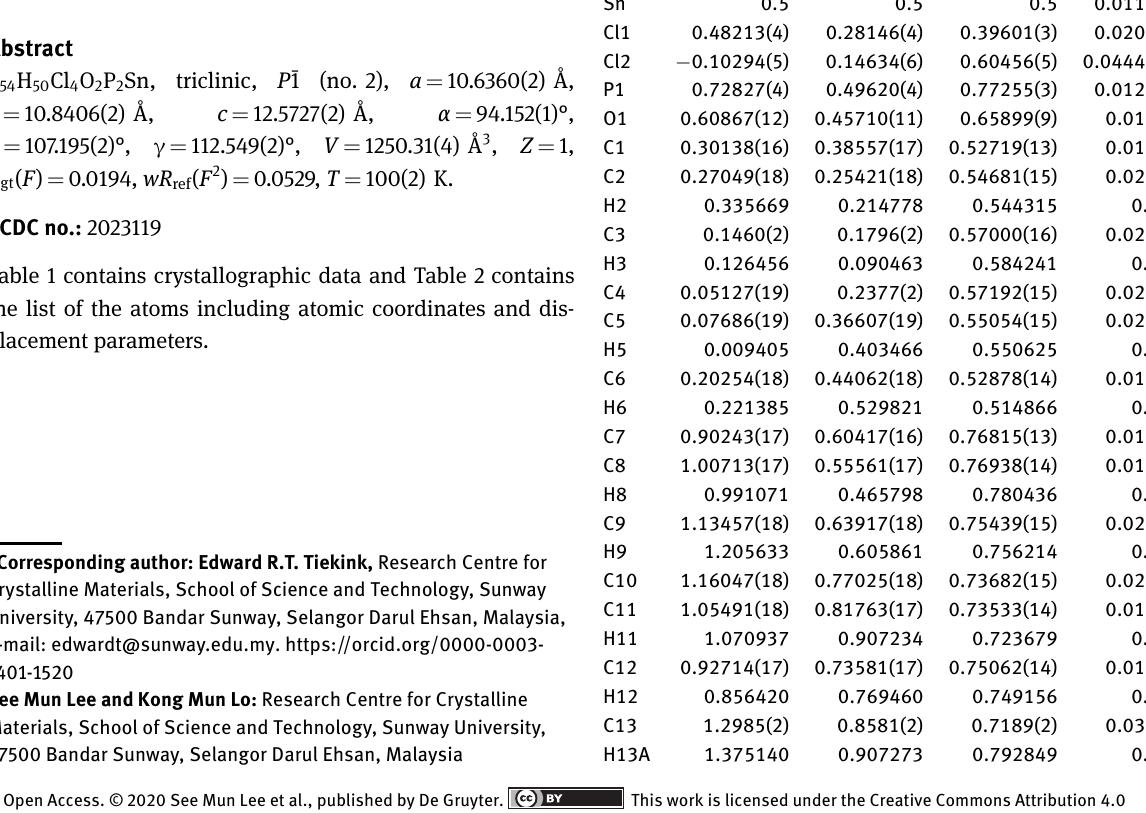
Table 1 contains crystallographic data and Table 2 contains the list of the atoms including atomic coordinates and dis- placement parameters.